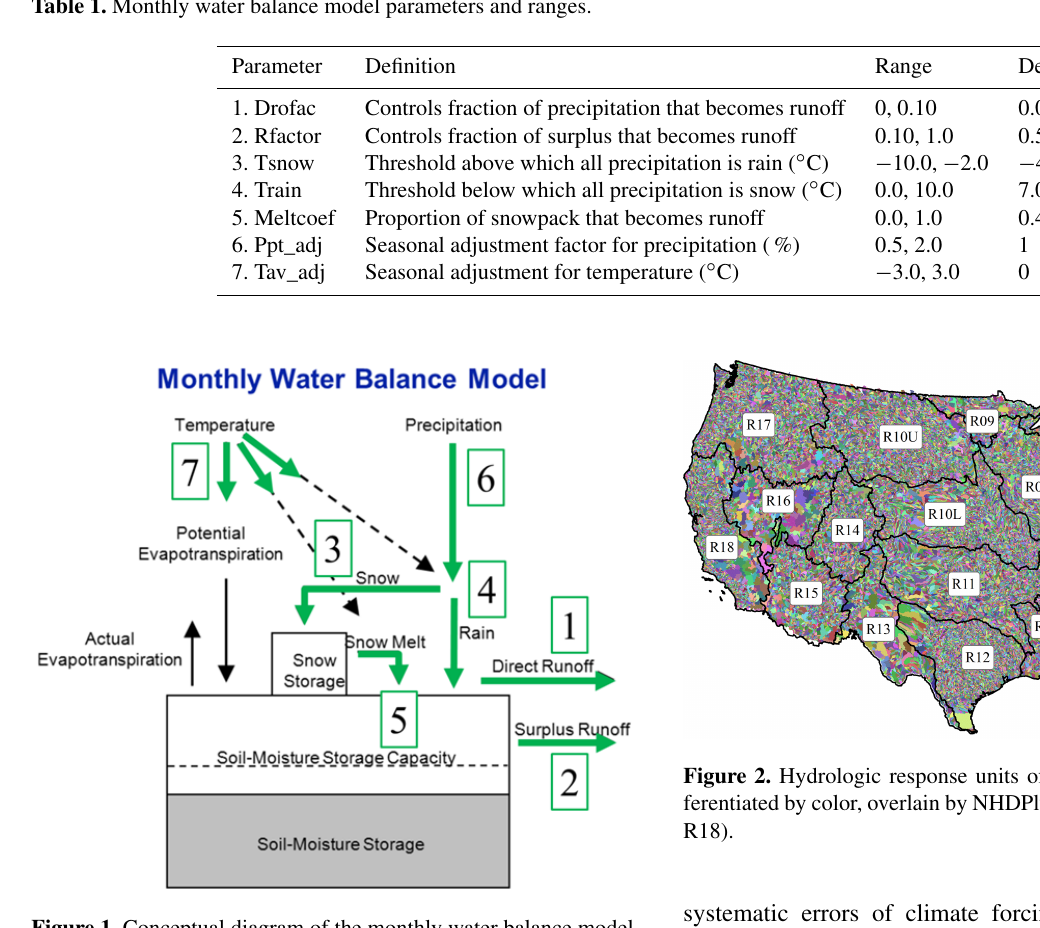
Figure 1. Conceptual diagram of the monthly water balance model (McCabe and Markstrom, 2007). Processes influenced by model parameters used in Fourier Amplitude Sensitivity Test (FAST) are those identified by green arrow and numbered 1–5 (Table 1).